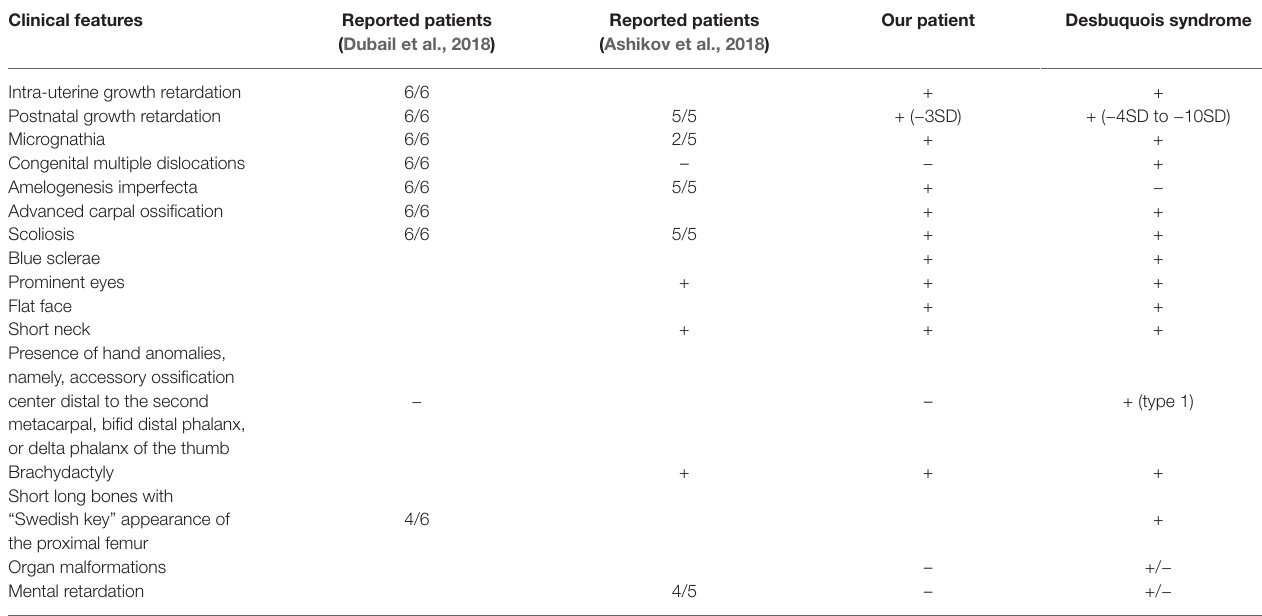
TABLE 1 | Review of the literature of SLC10A7 patients and clinical comparison with Desbuquois syndrome. Clinical